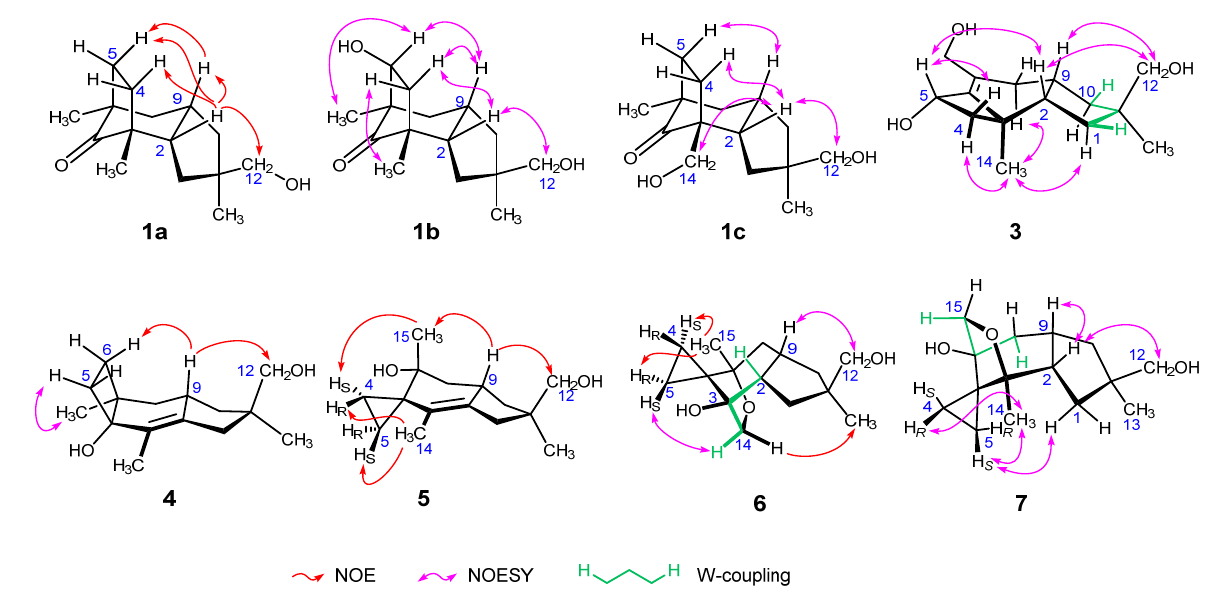
Figure 2. Representative NOEs, NOESY correlations, and long-range coupling of 1 – 7 . The ESI-TOFMS spectrum of tricocerapicanol B ( 1b ) exhibited the molecular ion at m / z 253.1802 (SI-15). The mass difference from 1a ( ∆ m/z 15.9933) indicated that 1b contains one more oxygen than 1a . The similar 2D spectral analysis as above allowed